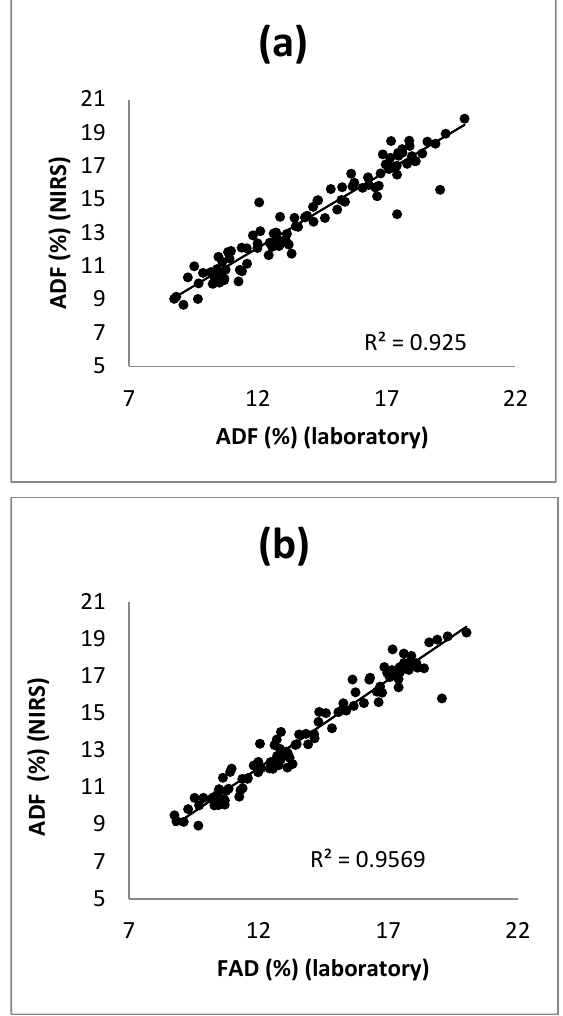
Figure 5. Scatter plot of the reference values against the predicted values in cross validation with respect to the ADF content applying the equations 1, 4, 4, 1 ( a ) and 2, 5, 5, 2 ( b ).